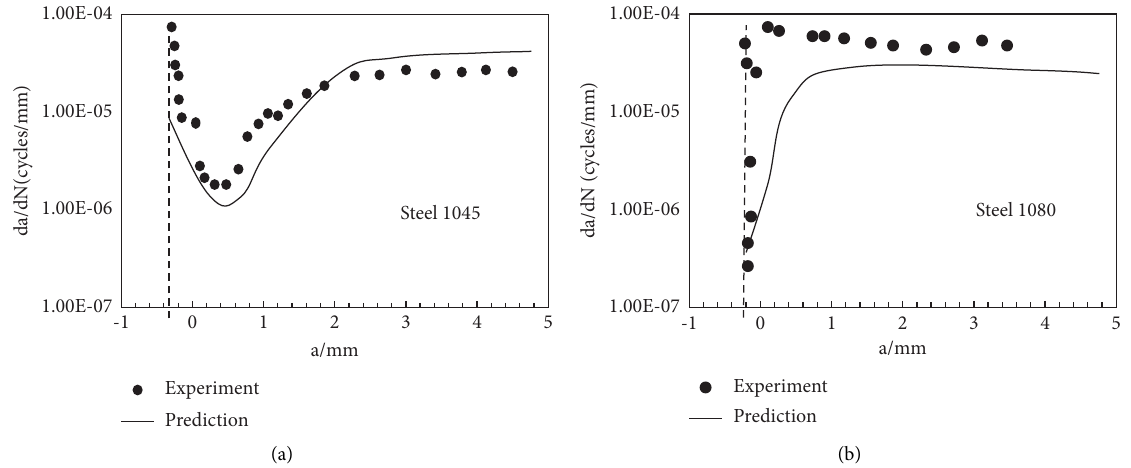
Figure 7: Comparison between the experimental data and estimated results for FCG rate of 1045 (a) and 1080 (b). 1.0E-071.0E-061.0E-051.0E-04